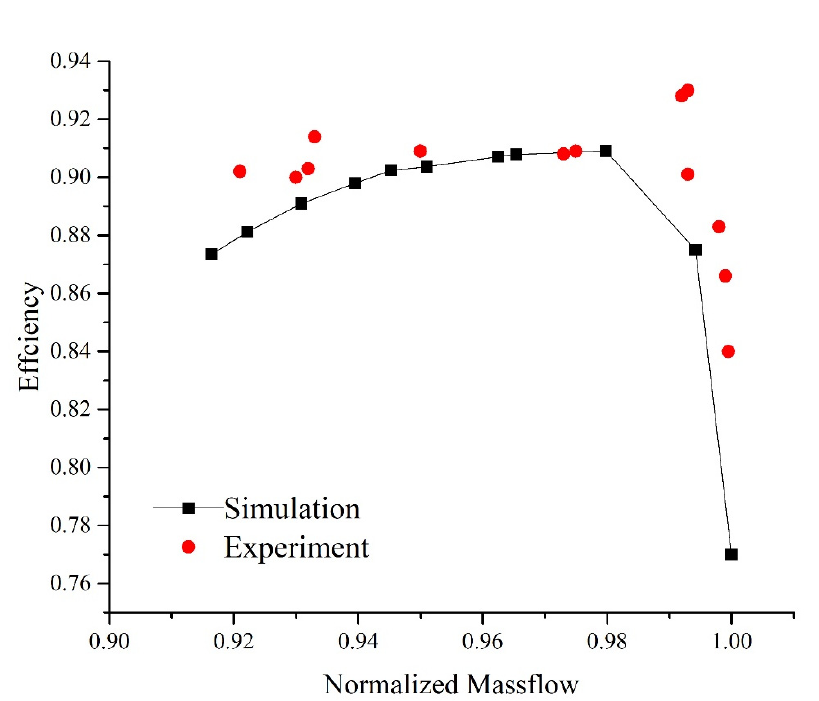
Figure 3. Computational domain and grids.